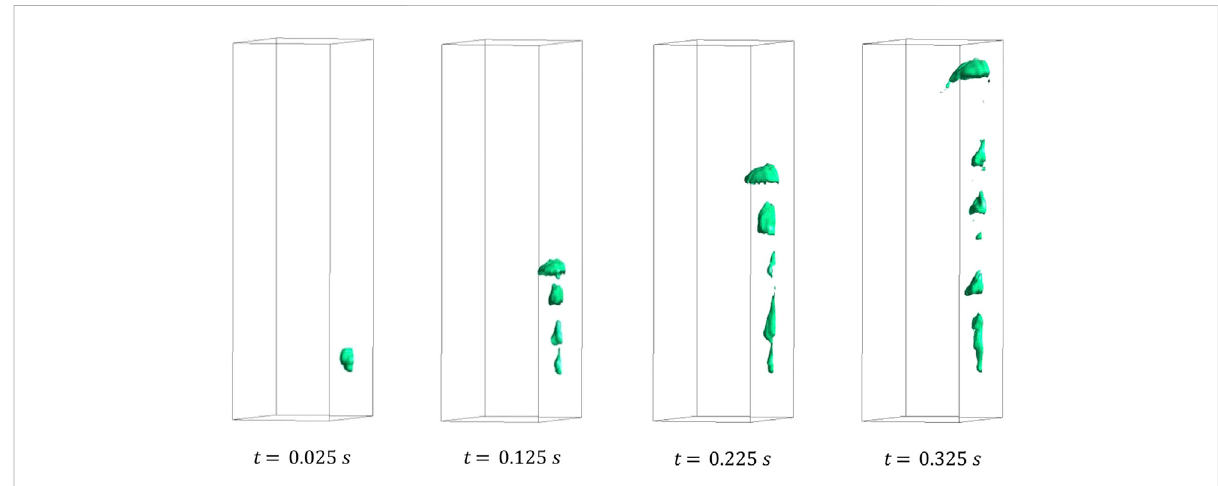
FIGURE 11 Snapshots of simulation of the bubbles generated by gas injection at the wall ori fi ce in molten LBE, v g (cid:1) 1 m / s